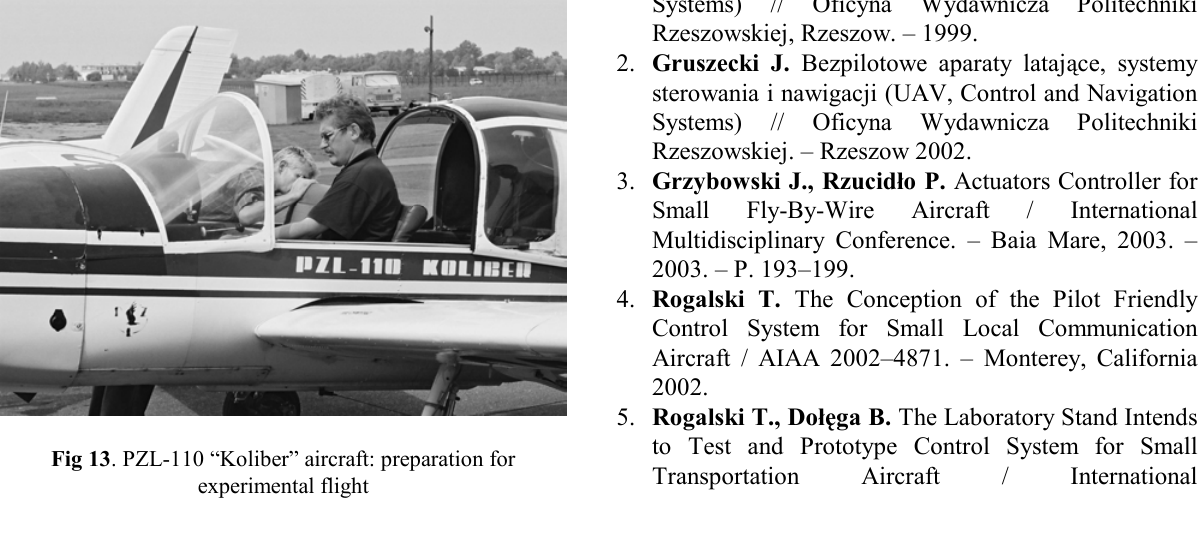
Fig 12. Actuator and controller installed on the board of the PZL-110 “Koliber” aircraft